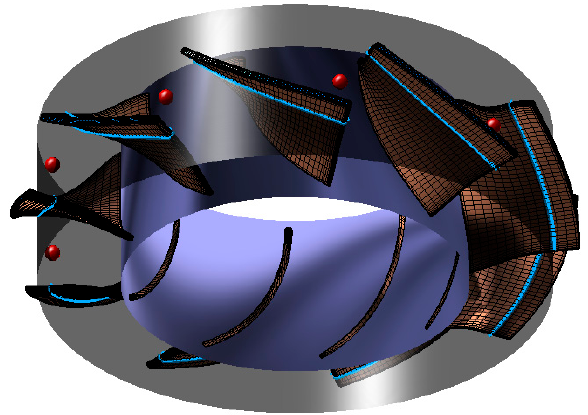
Figure 8. Location of monitoring points.